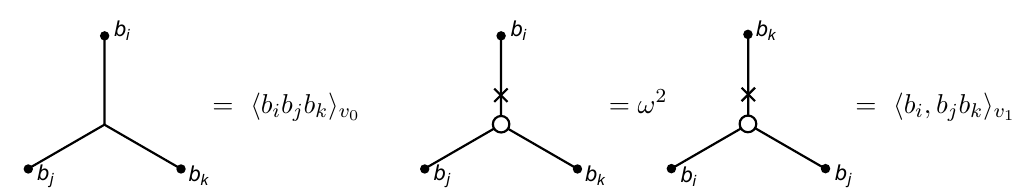
Figure 52 . Three-point function of defect operators b (cid:6) 2 H Y connected through a Y Y Y junction. The unmarked junction in the (cid:12)rst (cid:12)gure stands for the junction vector v 0 2 V Y;Y;Y , which is permutation invariant. The circle junction in the second (cid:12)gure stands for the junction vector v 1 , which transforms by the phase ! = e 2 (cid:25)i 3 under the cyclic permutation map.